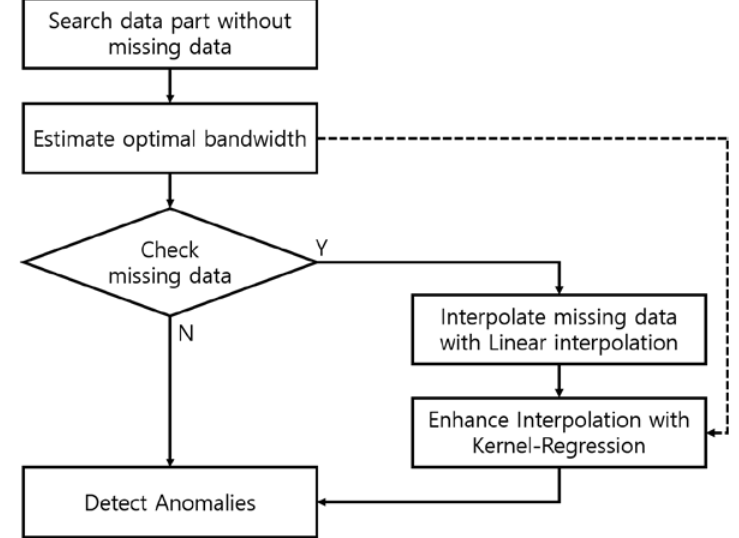
Figure 1. Flowchart of the proposed interpolation and anomaly detection.